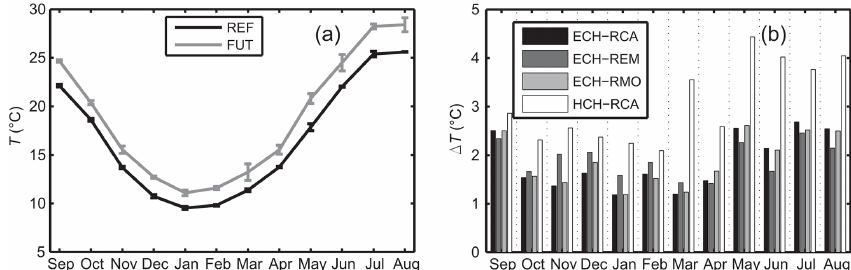
Figure 5. Same as Fig. 4, but for the mean monthly T .